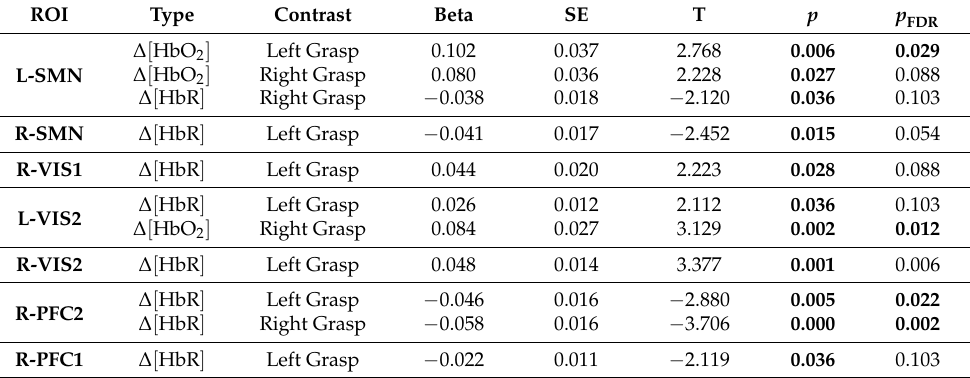
Table 3. Significant group-level contrasts between the ePD vs. mPD groups across ROIs, task conditions, and chromophores. Bold highlights significant